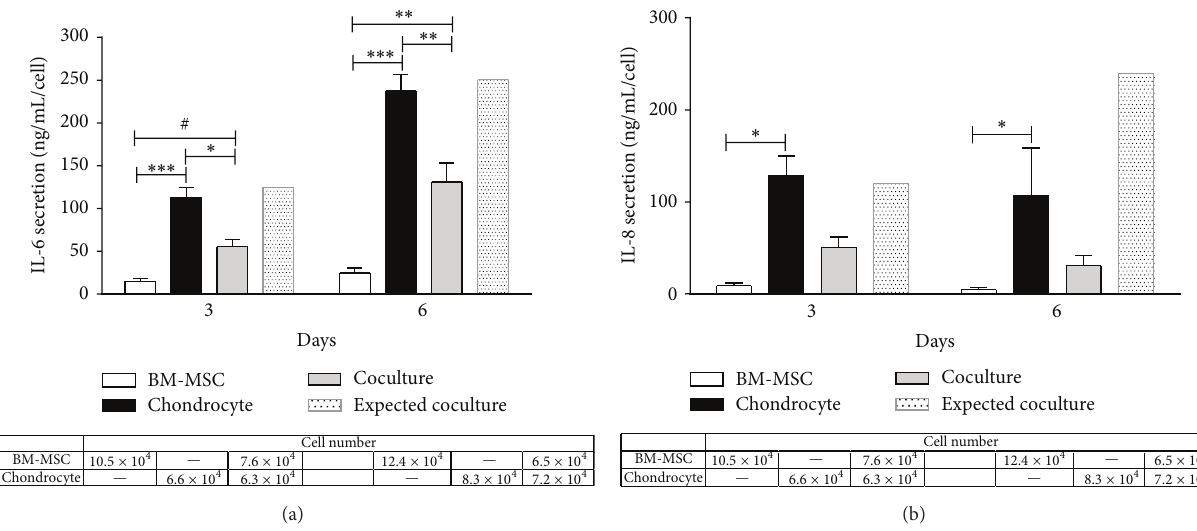
Figure6:OA-chondrocytesproducehigherIL-6andIL-8levelsthanBM-MSCsandcoculturedcellsanddecreasethesecytokines.Interleukin (IL)productionfor3and6daysinmonoculture( 𝑛 = 5 ;BM-MSCsandchondrocytes)orincoculture( 𝑛 = 5 ).IL-6concentration(ng/mL/cell) (a). IL-8 concentration (ng/mL/cell) (b). Overall, bars represent the mean value with the SEM; bars with gray line (expected coculture) show expected ILs synthesis in coculture, based on production of monoculture and cell number counted. Table shows cell number in each group. Statistical significance based on a two-way ANOVA with Tukey’s posttest was set according to the number of asterisks, as follows: ∗ 𝑃 ≤ 0.05 , ∗∗ 𝑃 ≤ 0.001 , and ∗∗∗ 𝑃 ≤ 0.0001 . Tendency of statistical differences between cell culture groups was identified by